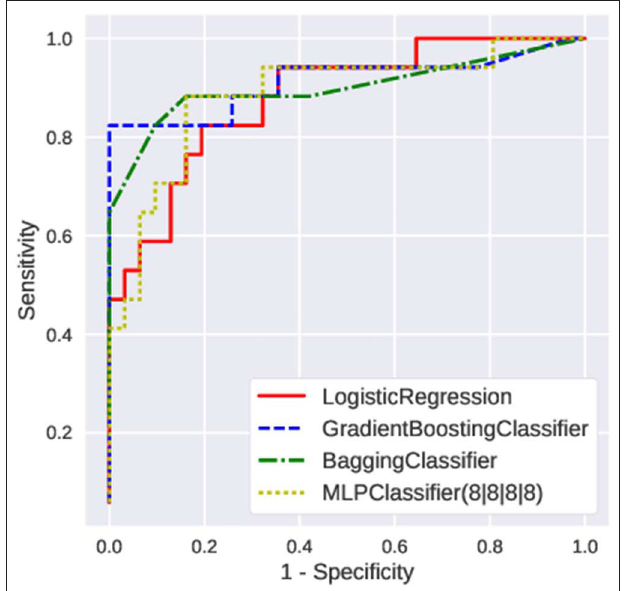
FIGURE 4 | The ROC curve of typical machine learning algorithms.